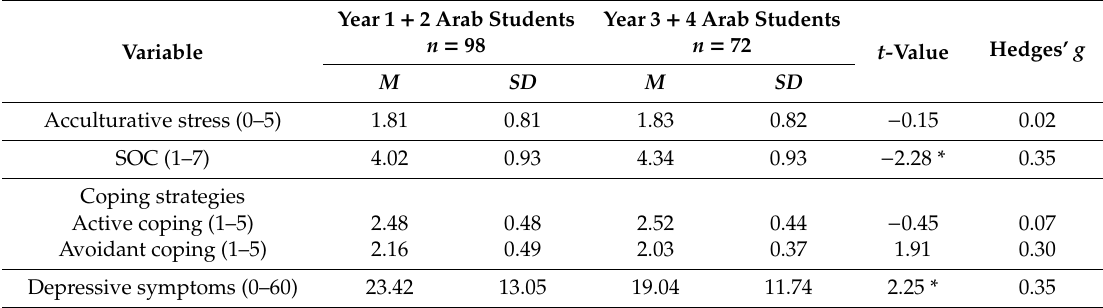
Table 3. Academic-year di ff erences in acculturative stress, SOC, active coping, avoidant coping, and depressive symptoms.